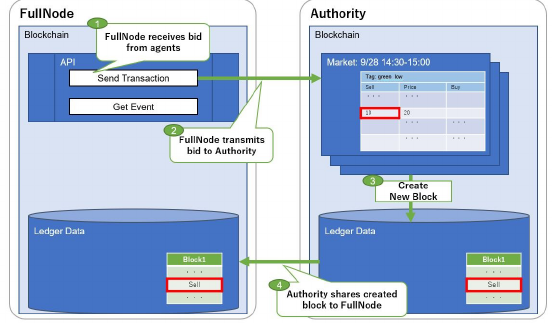
Figure 2. Blockchain system